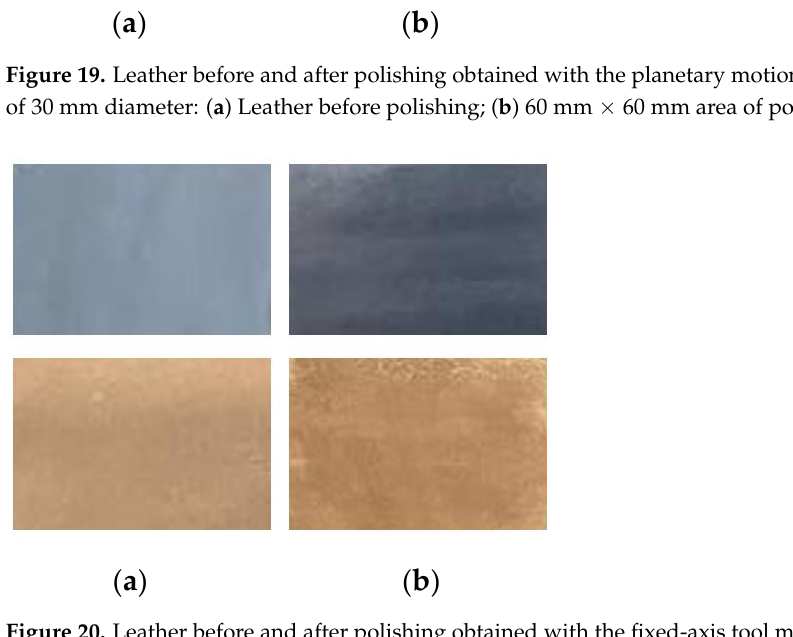
Figure 20. Leather before and after polishing obtained with the fixed-axis tool motion and a backing pad of 15 mm diameter: ( a ) Leather before polishing; ( b ) 50 mm × 40 mm area of polished leather. These first results are obtained by setting the parameters reported in Tables 1 and